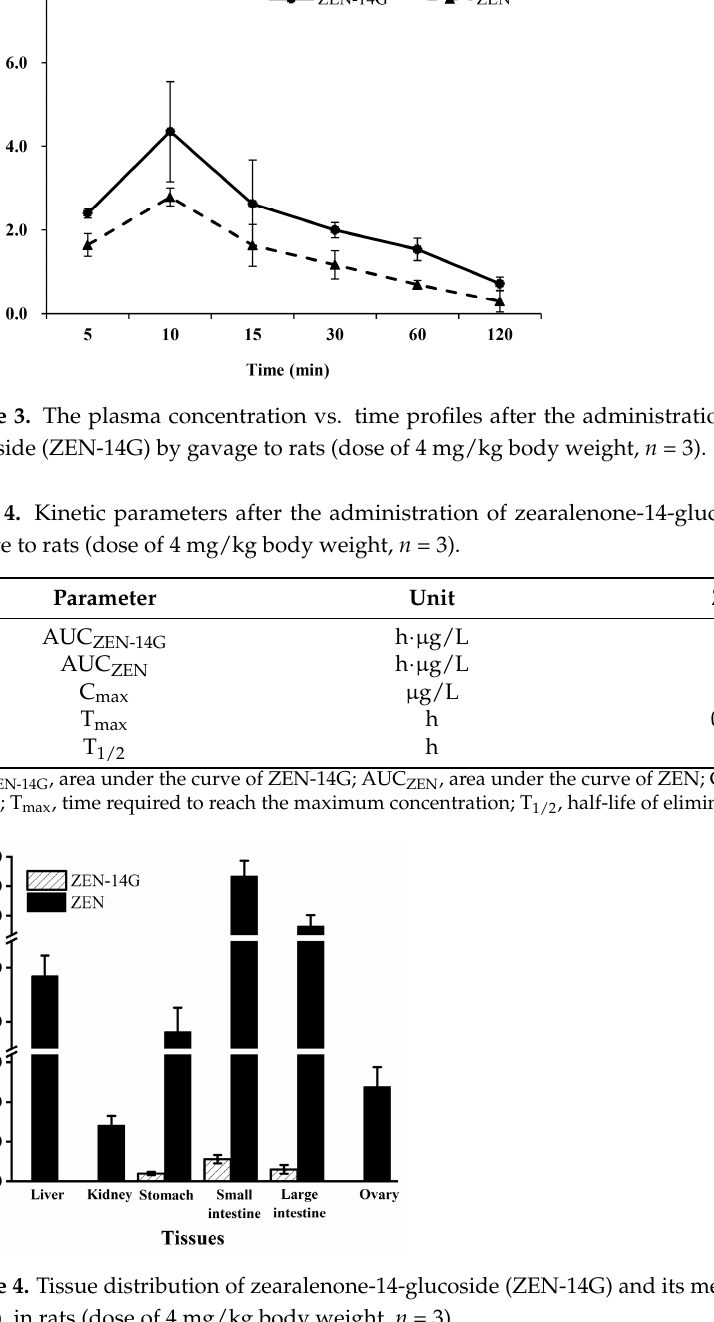
Figure 5. The concentrations of zearalenone-14-glucoside (ZEN-14G) and zearalenone (ZEN) in urine collected 6–24 h after oral administration to rats (dose of 4 mg/kg body weight, n = 3).